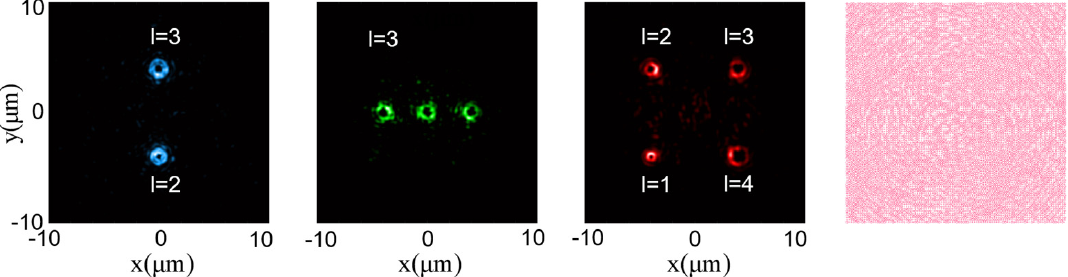
Figure 10. The first three images from left to right, respectively, represent the normalized intensity distribution of the focal planes of B, G, and R waves. The final image is the gds layout of the metalens structure.